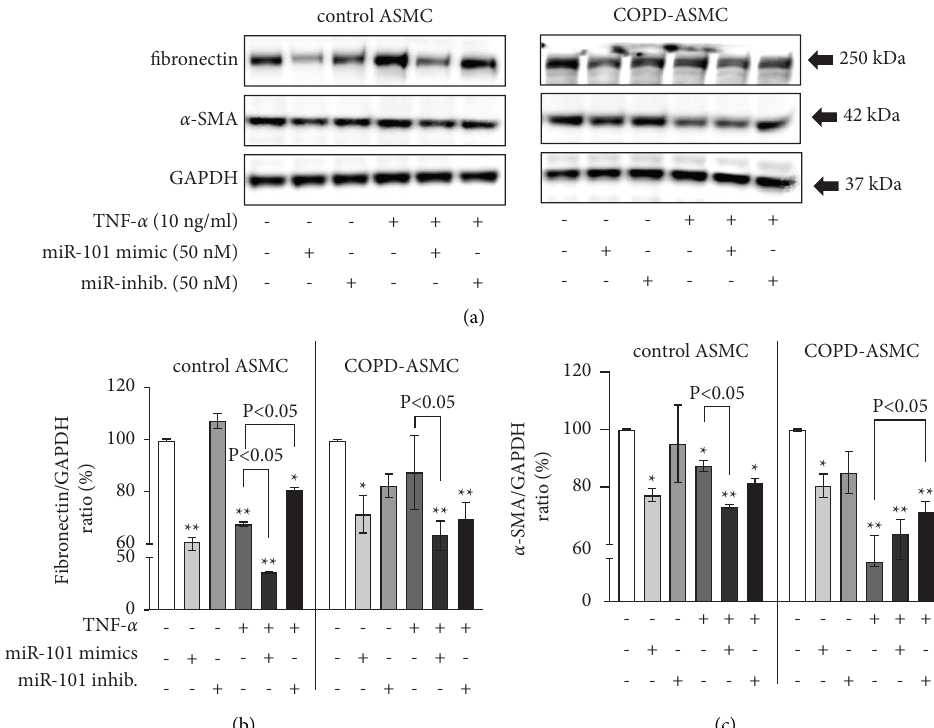
Figure 7: Te additive efect of miR-101-3p and TNF- α on ASMC deterioration. (a) Western blots of disease-specifc 24 hours efect for miR-101-3p mimics and inhibitors on the baseline expression of fbronectin and α -SMA expression in AMSC of healthy nonsmokers ( n � 3) and COPD ( n � 3). (b) Image analysis of fbronectin Western blots in ASMC of healthy nonsmokers and COPD, as shown in Figure 7(a). (c) Image analysis of α -SMA Western blots in ASMC of healthy nonsmokers and COPD, as shown in Figure 7(a). Bars represent mean ± S.E.M. “ ∗ ” � P < 0 . 05 and “ ∗∗ ” � P < 0 . 01 are compared to untreated